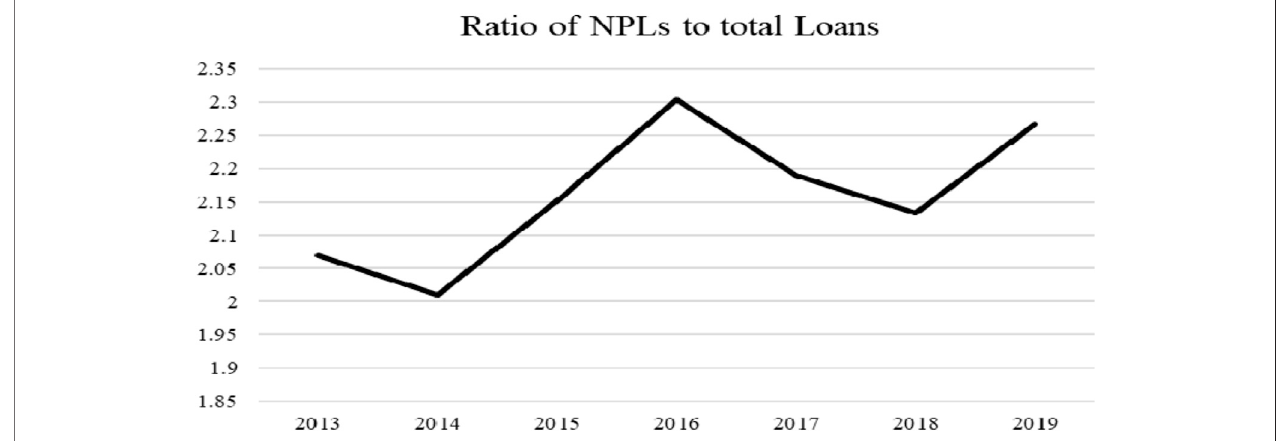
FIGURE 2 | NPLs to the total loan ratio of four ASEAN countries (Indonesia, Malaysia, the Philippines, and Thailand). Source: the World Bank Website.